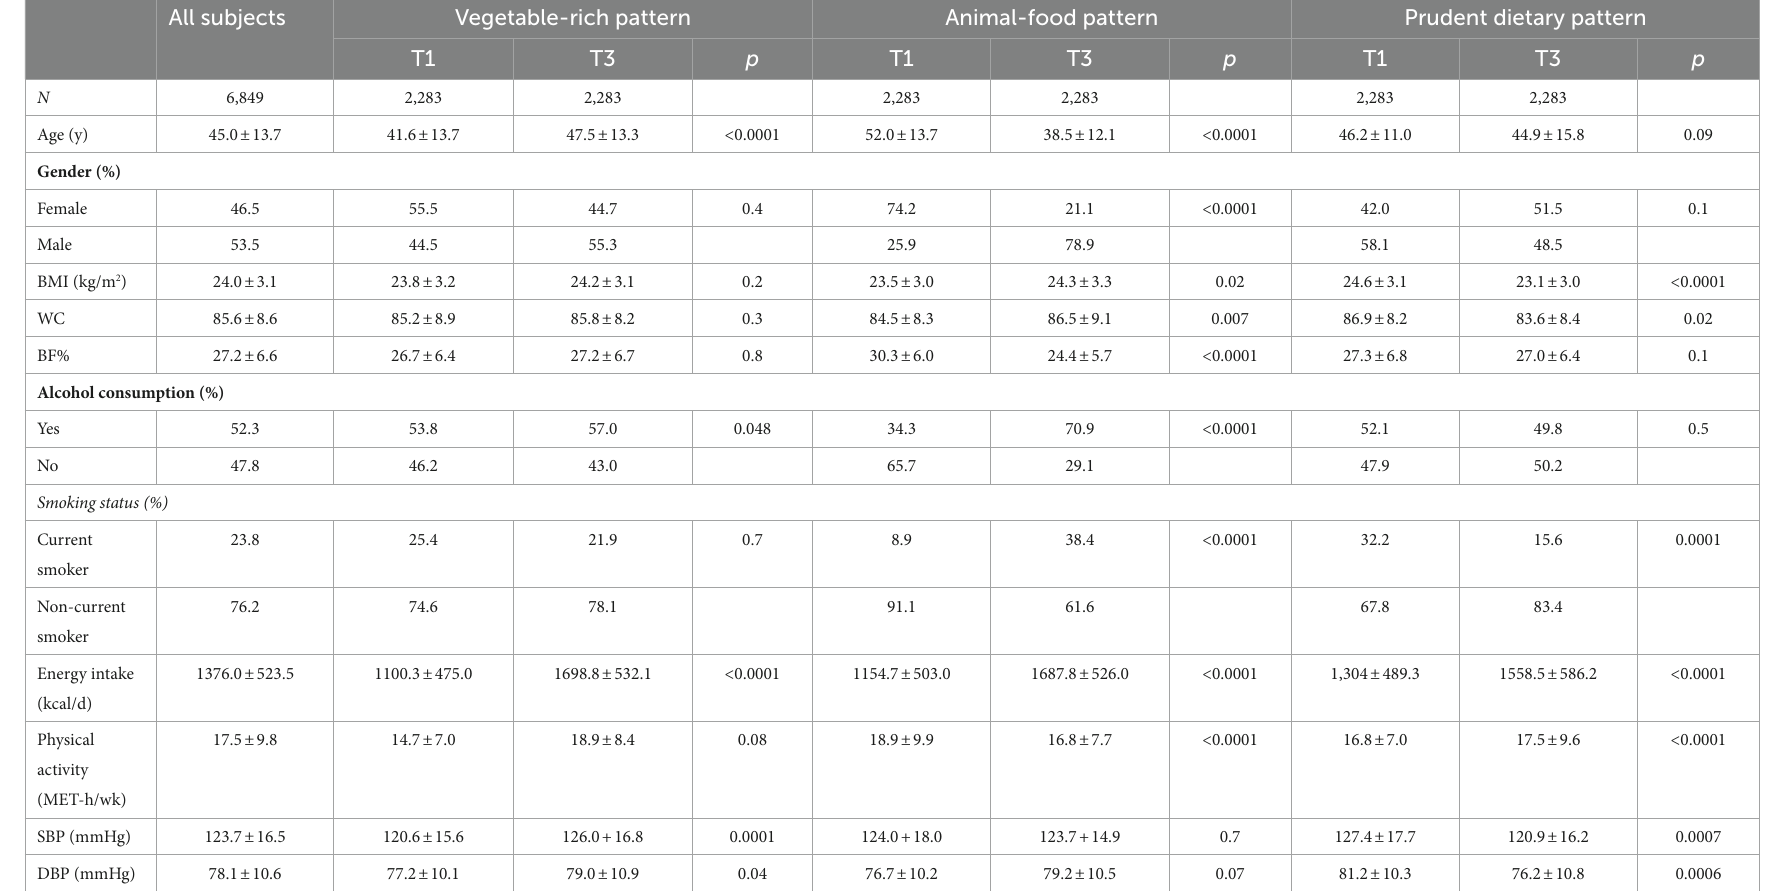
TABLE 3 Participant characteristics according to categories of dietary patterns a . All subjects Vegetable-rich pattern Animal-food pattern Prudent dietary